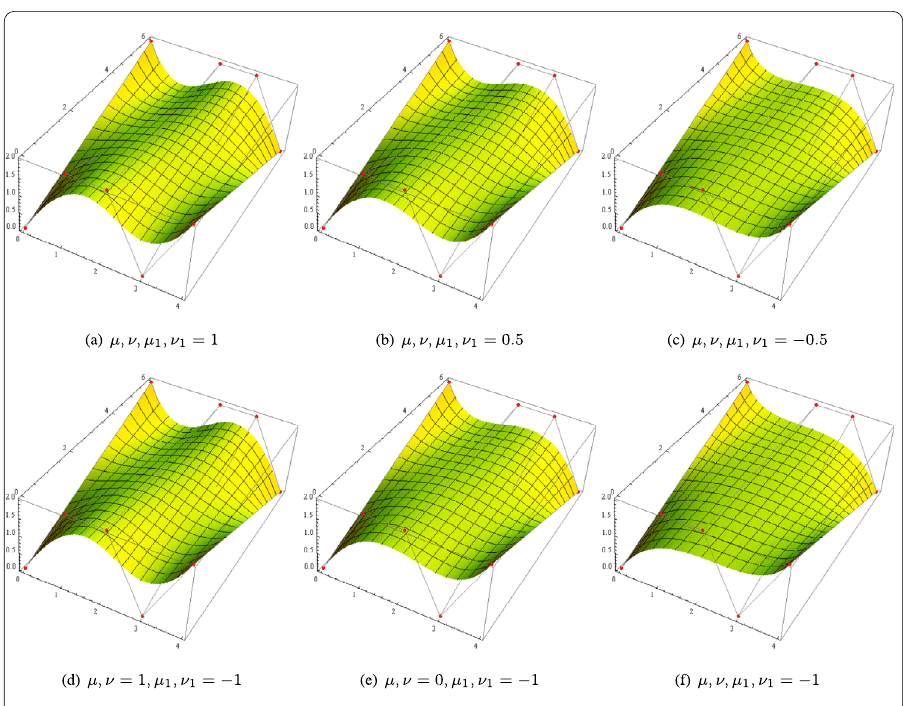
Figure 9 GBT-Bézier ruled surfaces with different shape